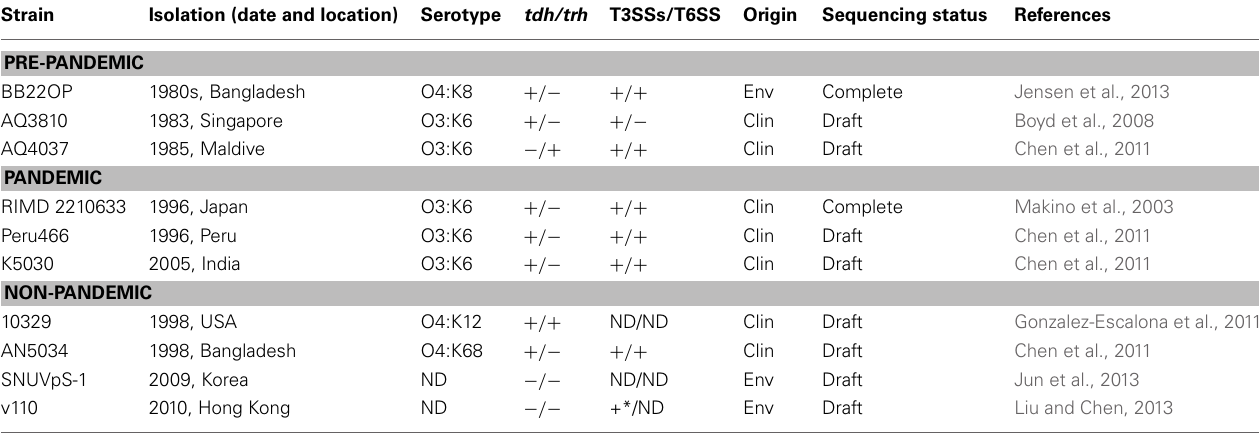
Table 1 | V. parahaemolyticus strains that have been sequenced. Strain